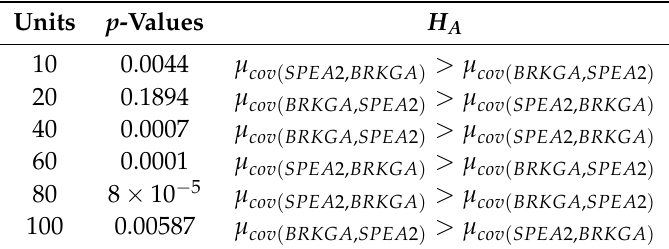
Table 16. Results of Wilcoxon Rank-Sum